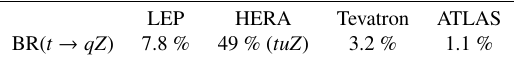
Table 3. Present experimental 95% CL upper limits on the BR of the FCNC top quark decay channels (list is not